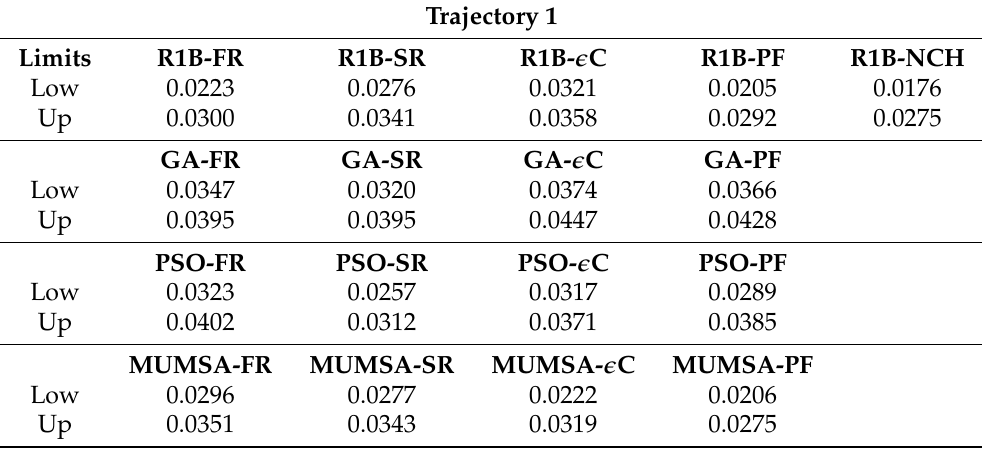
Table 9. Confidence interval values of algorithm for study case 1 in both